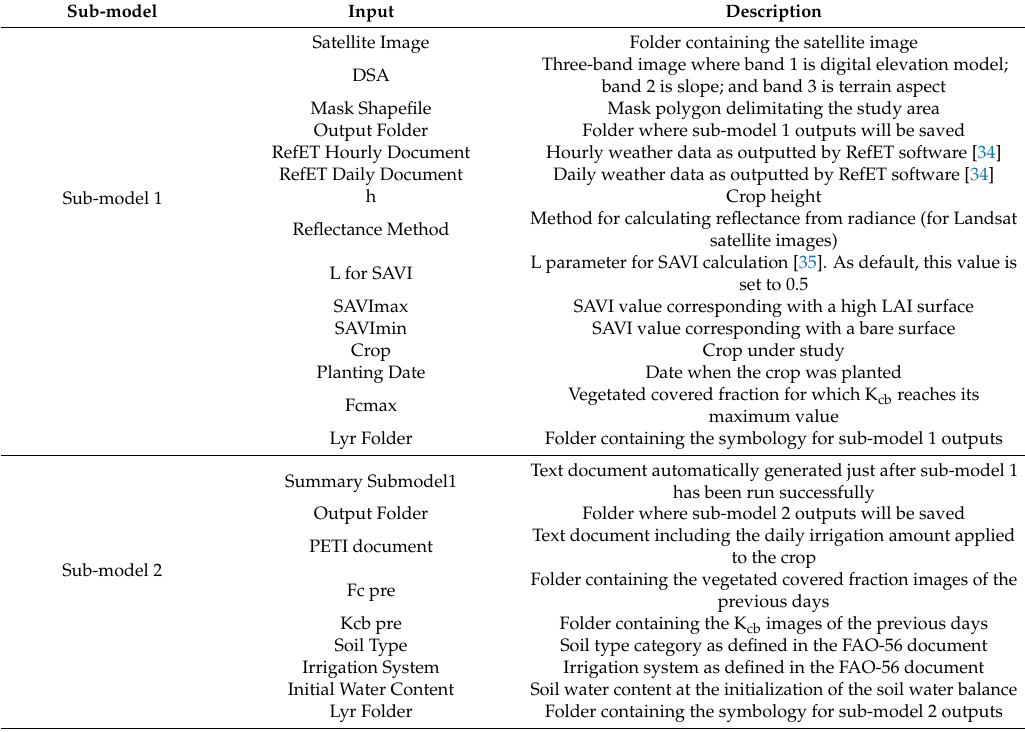
Table 4. Description of the different inputs considered in each sub-model. FAO—Food and Agricultural Organization of the United Nations; RefET—reference evapotranspiration; SAVI—soil-adjusted vegetation index; LAI—leaf area